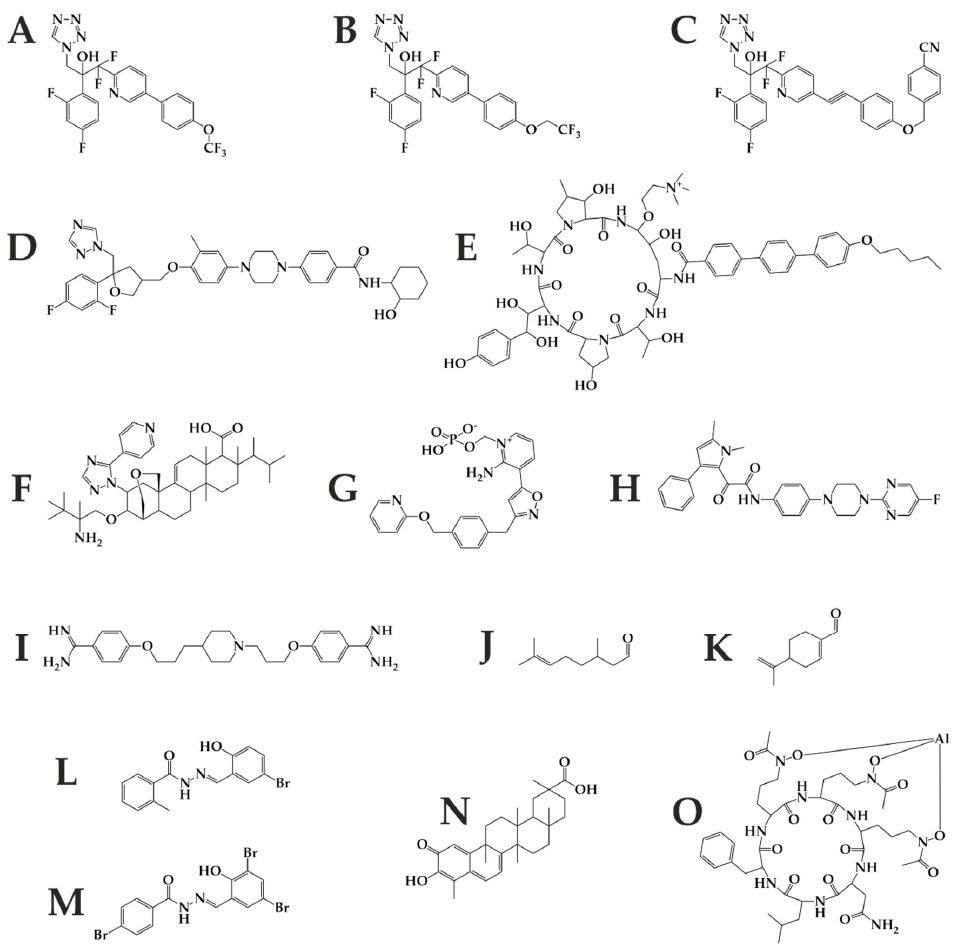
Figure 7. Future antifungal therapy may benefit from these substances including tetrazoles VT-1129 ( A ), VT-1161 ( B ), VT-1598 ( C ); triazole PC1244 ( D ); echinocandin rezafungin ( E ); triterpenoid Ibrexafungerp ( F ); inositol transferase inhibitor Fosmanogepix ( G ); dihydroorotate dehydrogenase inhibitor Olorofim ( H ); histone deacetylase inhibitor MGCD290 ( I ); monoterpenoids citronellal ( J ) and perillaldehyde ( K ); brominated acylhydrazones BHBM ( L ) and its derivative D13 ( M ); triterpenoid celastrol ( N ); and hydroxamate type siderophore VL-2397 ( O ).